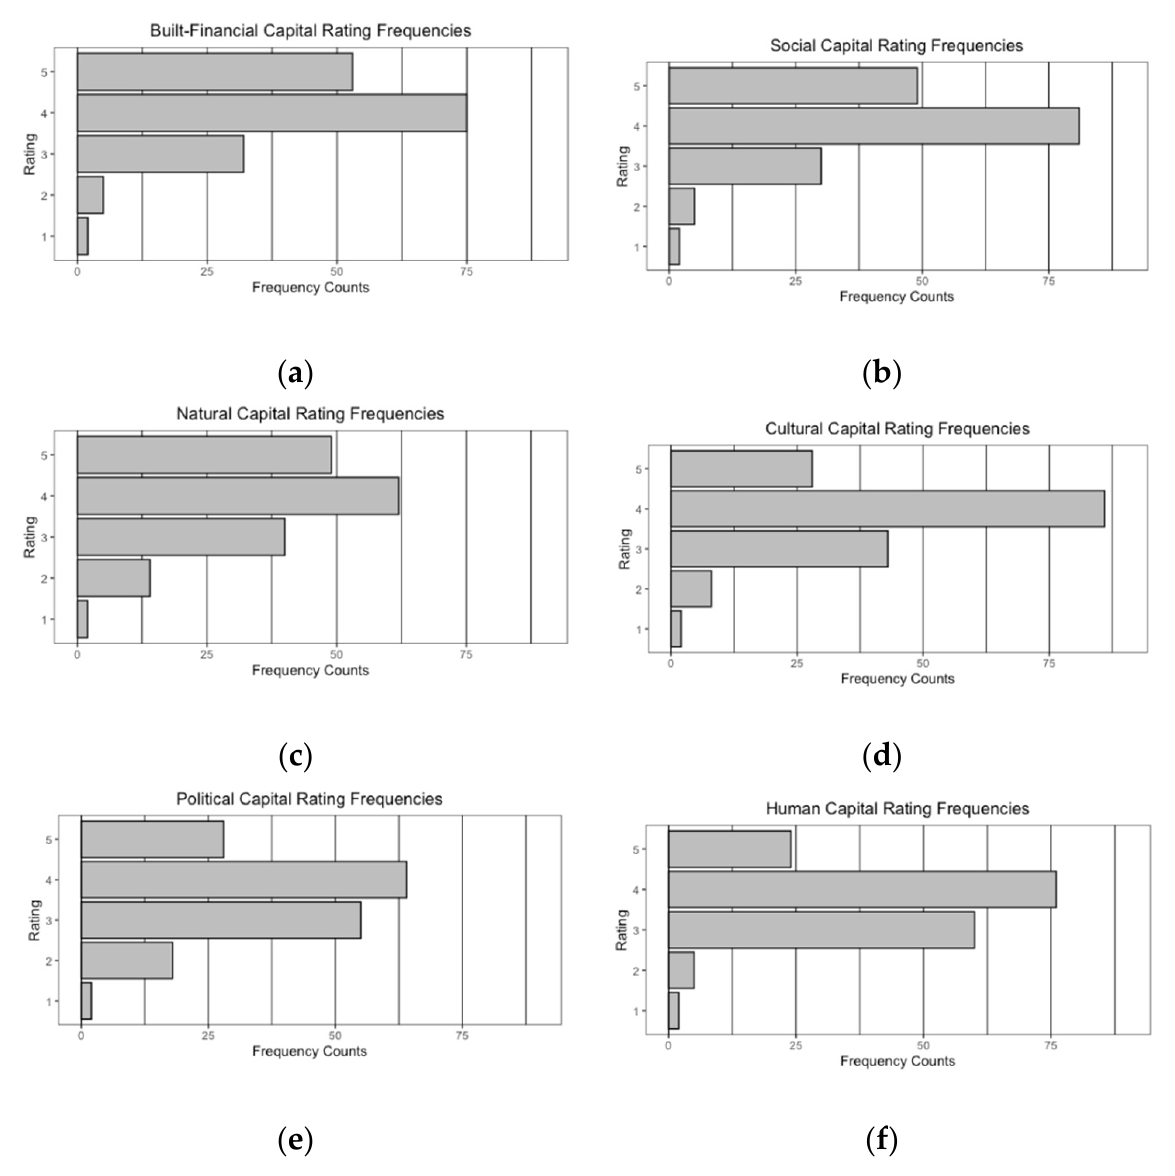
Figure 1. Absolute Frequency Distributions for Community Capital Rating Data: ( a ) Built–Financial; ( b ) Social; ( c ) Natural; ( d ) Cultural; ( e ) Political; ( f ) Human. Table 2. Absolute Ranking Frequency Counts for Single